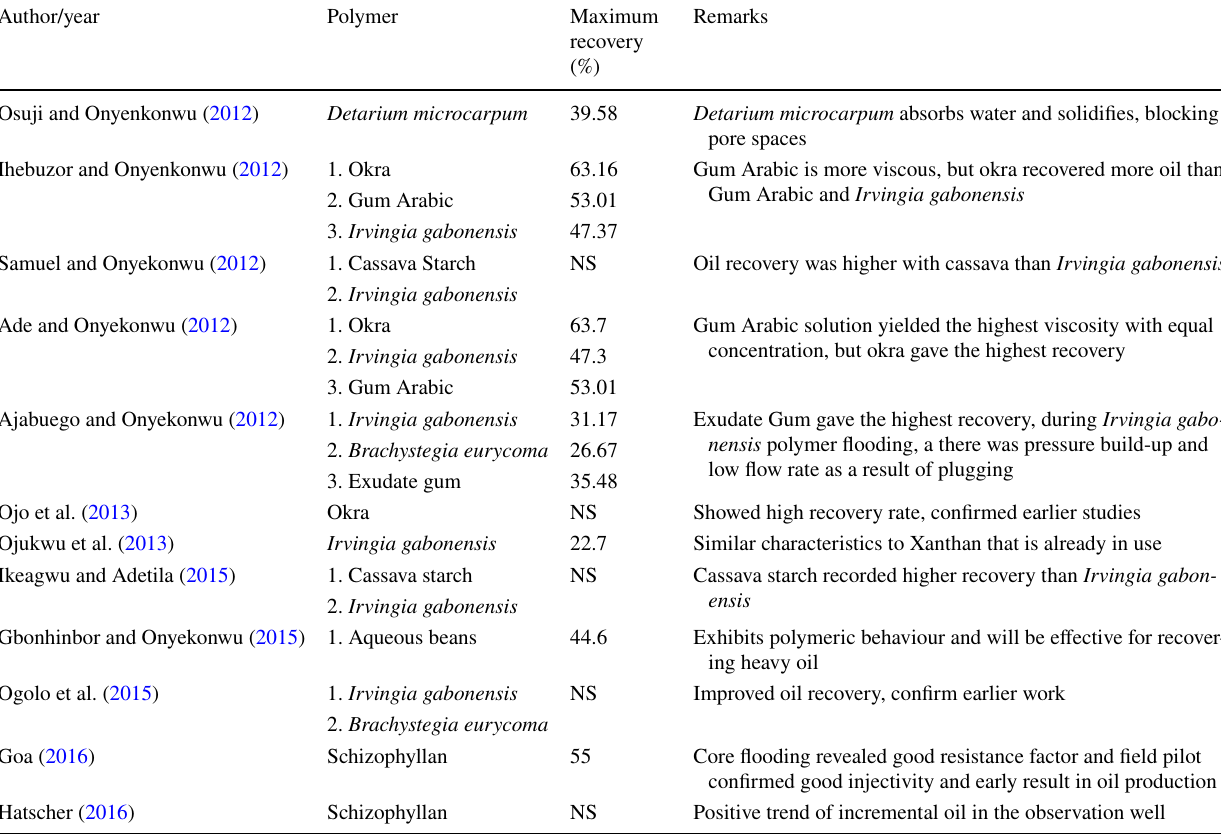
Table 3 List of studies on oil recovery in natural polymer